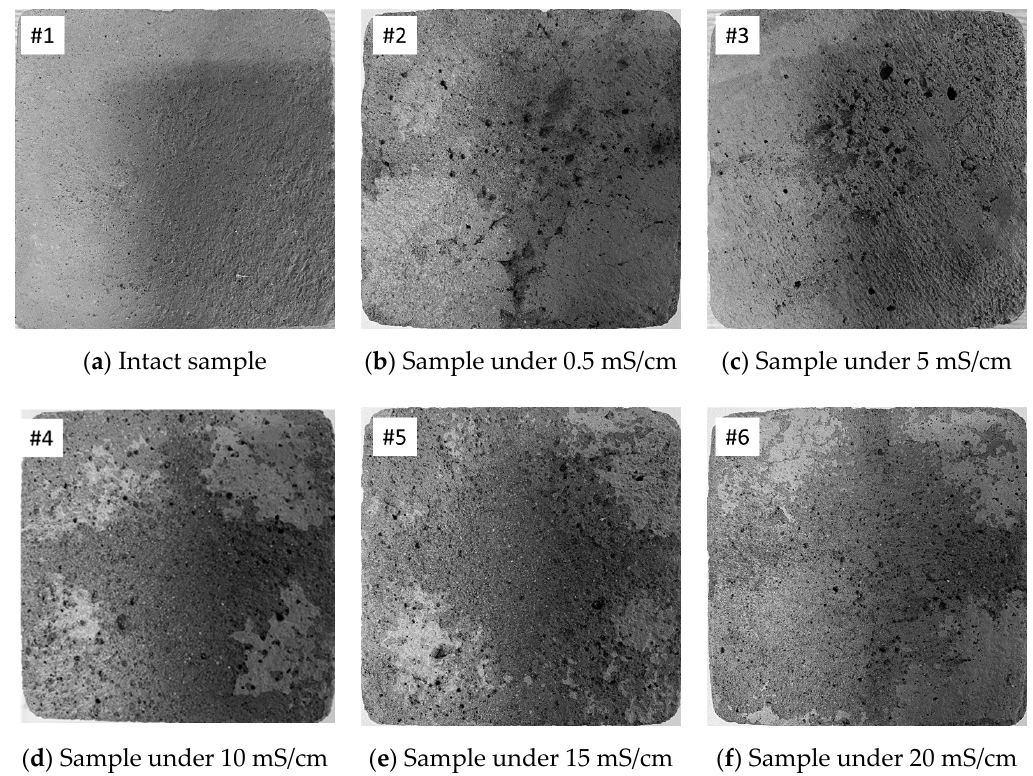
Figure 12. Typical surface macro-damage features of samples under different electrical conductivity.